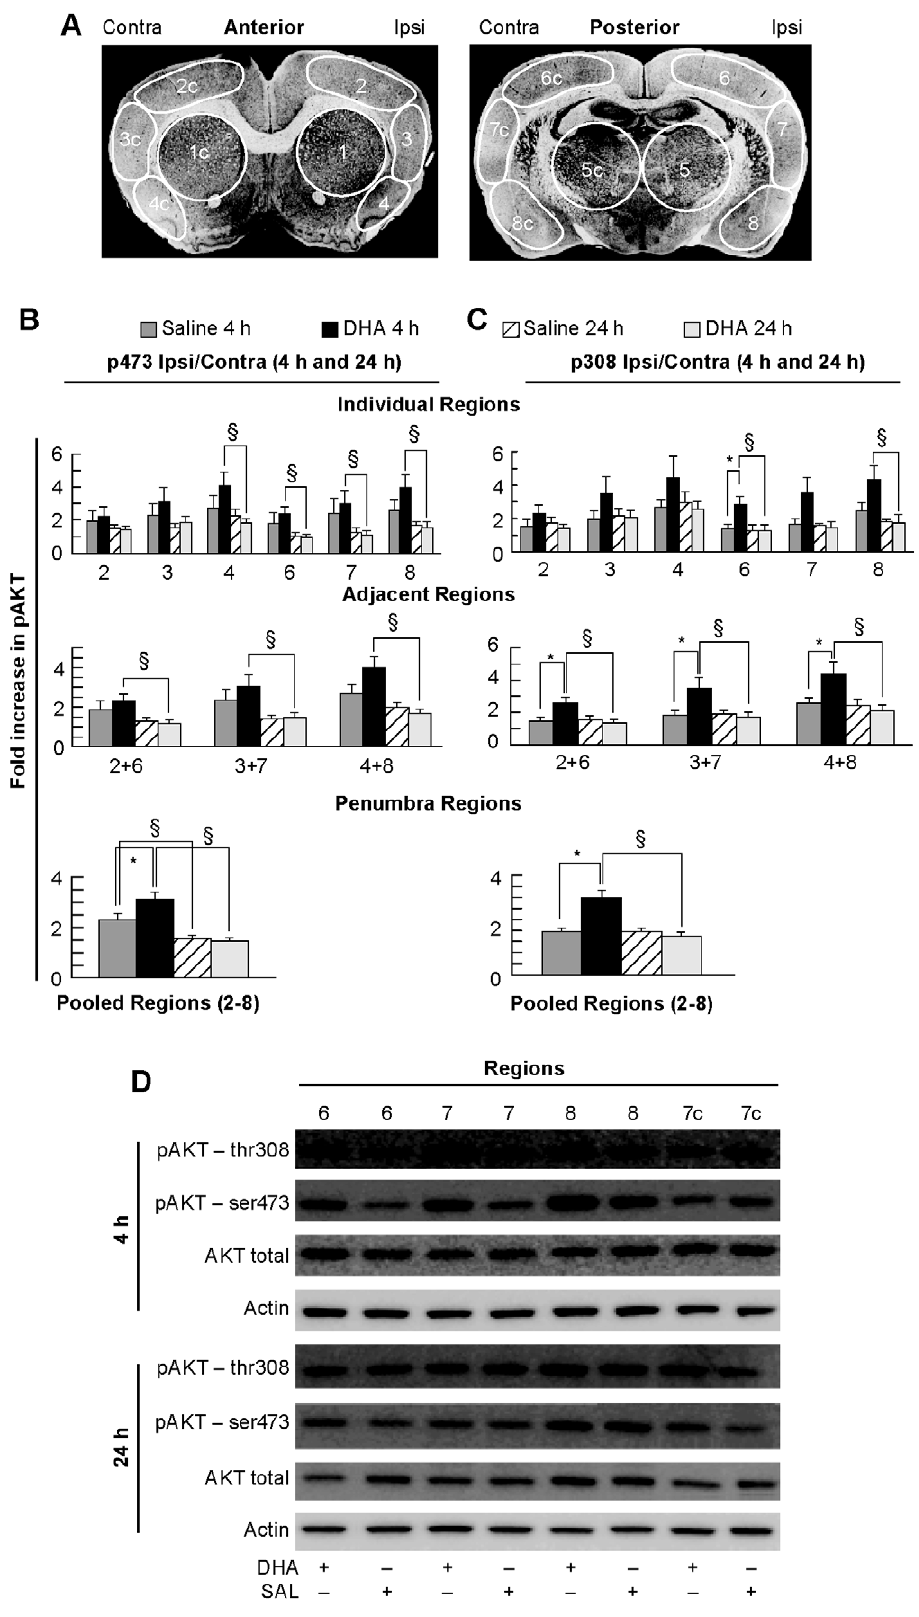
Figure 2. AKT phosphorylation in young animals. Panel A: Schematic of coronal brain diagrams (bregma levels + 1.2 and 2 1.8 mm) showing locations of regions for western blot analysis, conducted at 4 and 24 h after onset of stroke. Individual regions of the penumbra (2, 3, 4 and 6, 7, 8)